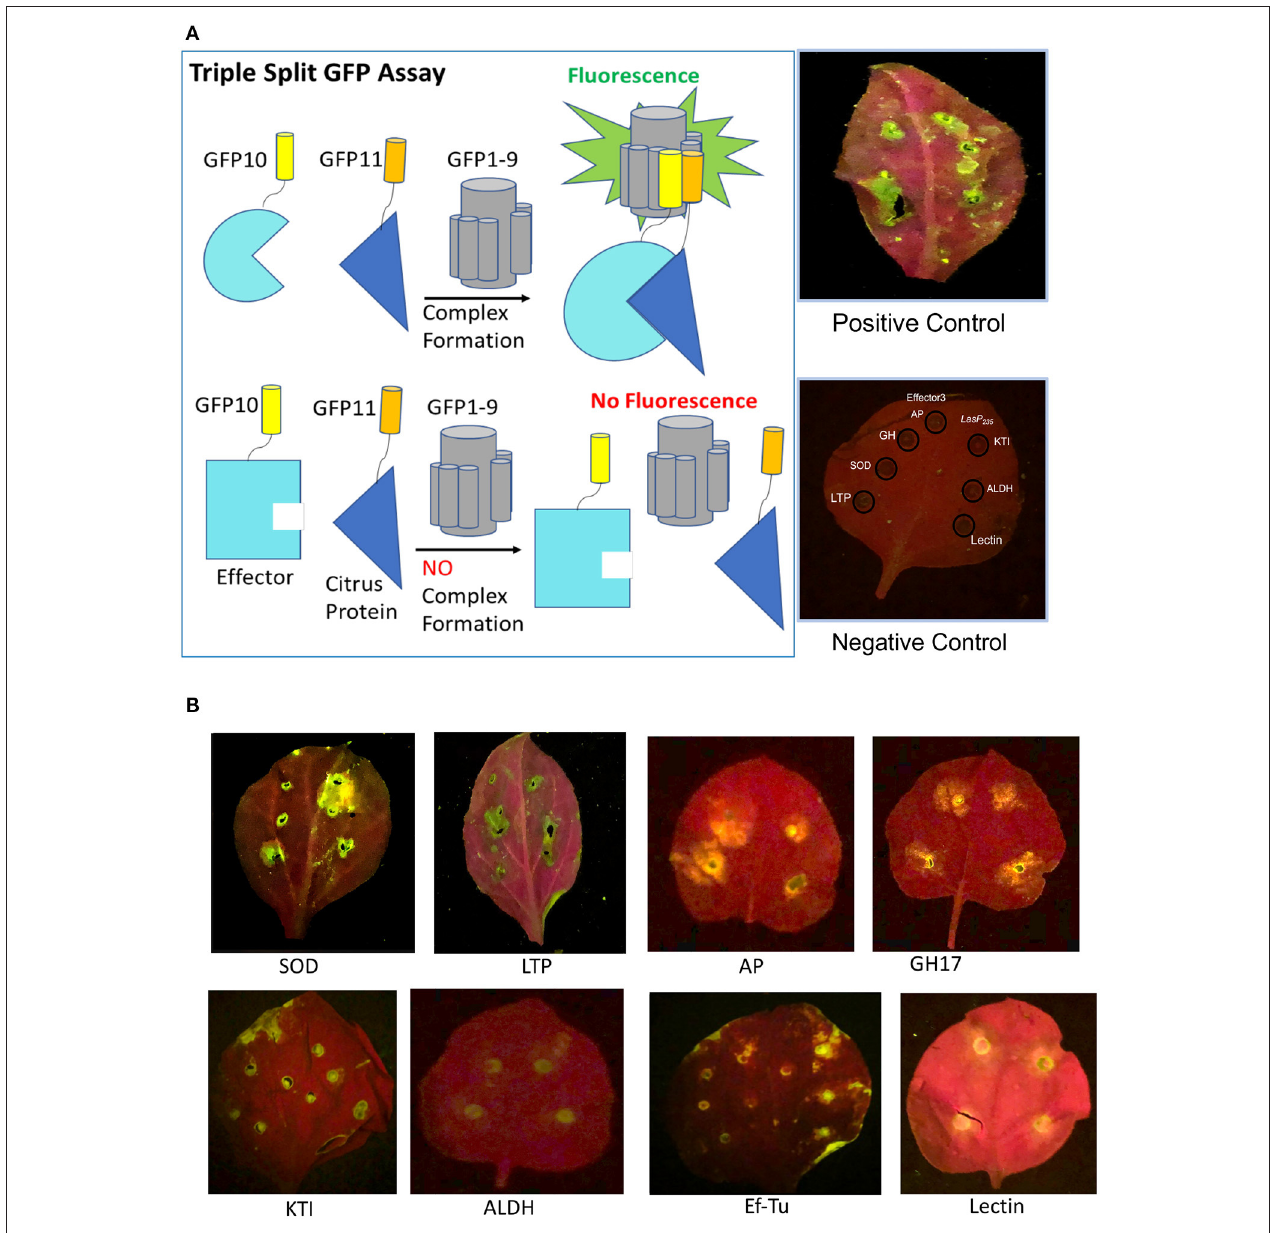
FIGURE 2 | In planta validation of the selected citrus protein targets of LasP 235 and Effector 3 by triple split GFP assay. [ (A) , left] A schematic representation of the principle of the triple split GFP assay. Green fluorescence is observed when the Effector (cyan) linked to GFP10 (yellow) interacts with the target (blue) linked to GFP11 (orange) and the effector-target complex complements with GFP1-9. There is no fluorescence in the absence of an interaction. [ (A) , right] The presence of fluorescence when agrobacterium carrying enhanced GFP is infiltrated on the leaves of transgenic tobacco expressing GFP1-9 is used as a positive control. Absence of fluorescence when the leaves of transgenic tobacco expressing GFP1-9 co-infiltrated with LasP 235 and the interactors of Effector 3 in one-half of the leaf (or Effector 3 and the interactors of LasP 235 in the other half of the leaf) served as the negative controls. Note the absence of fluorescence. Under the 488nm excitation filter (blue) and colored glass 520nm long pass filter, the chlorophyll background appears as red and fluorescence at the site of co-infiltration of the effector and its target appears as greenish yellow spots. (B) Complex formation when LasP 235 is co-infiltrated with SOD, LTP, AP, and GH17 in the leaves of GFP1-9 transgenic tobacco (top panel) and when Effector 3 is co-infiltrated with Effector 3 and KTI, ALDH, Ef–Tu, and Lectin (bottom panel).